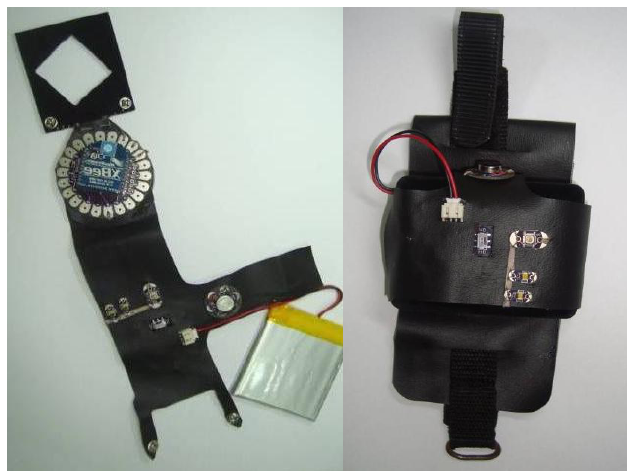
Figure 4. xGroupware bracelet.